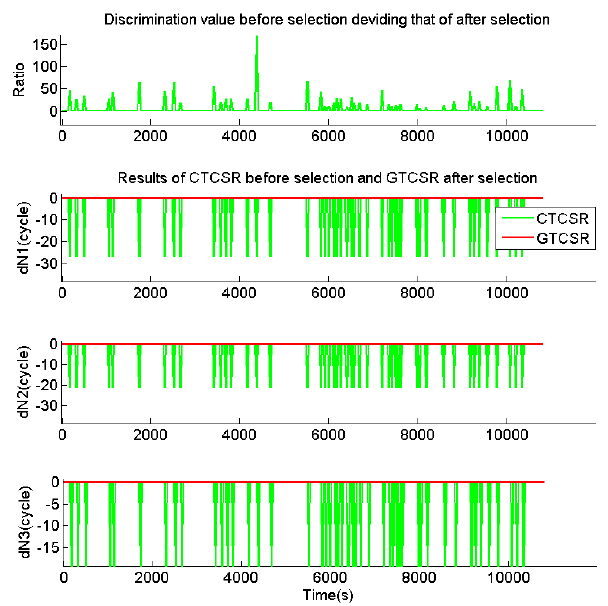
Figure 6. Original cycle slips from CTCSR before selection and GTCSR after selection, where the epoch-difference pseudoranges have been appended with gross errors of 2.5 m epoch by epoch and the phases are without cycle slips on GPS satellite 10 at CUT0 station during the geomagnetic storm that started from UTC 2016/05/08 00:00:00; CTCSR is the conventional CSR with triple-frequency optimized combinations.